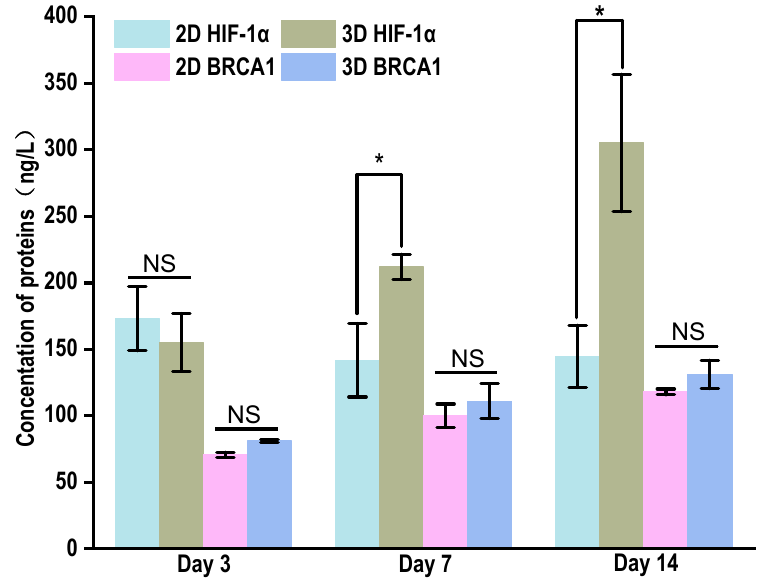
Figure 8. The expression of HIF-1 α and BRCA1 in culture supernatant of MCF-7 cells in 2D and 3D culture system by ELISA. NS—not significant, p > 0.05; * p < 0.05.